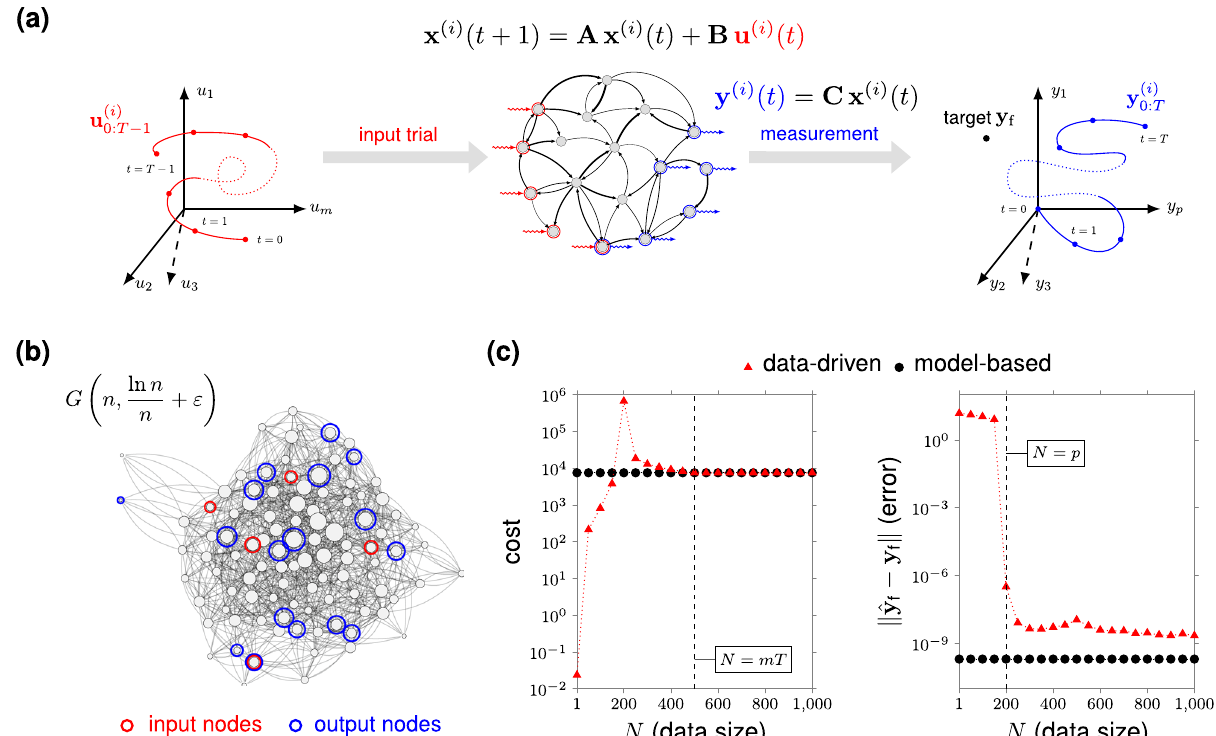
Fig. 2 Experimental setup and optimal data-driven network controls. Panel ( a ) illustrates the data-collection process. With reference to the i th control experiment, a T -step input sequence u ð i Þ excites the network dynamics in Eq. (1), and the time samples of the resulting output trajectory y ð i Þ are recorded. 0 : T 0 : T The input trajectory u ð i Þ may be generated randomly, so that the fi nal output y ð i Þ T does not normally coincide with the desired target output y f . Red nodes 0 : T denote the control or input nodes (forming matrix B ) and the blue nodes denote the measured or output nodes (forming matrix C ). Panel ( b ) shows a realization of the Erdös – Rényi graph model G ( n , p edge ) used in our examples, where n is the number of nodes, p edge is the edge probability. We set the edge ffiffiffi p n probability to p ¼ lnn = n þ ε , ε = 0.05, to ensure connectedness with high probability, and normalize the resulting adjacency matrix by . Panel ( c ) edge shows the value of the cost function (left) and the (norm of the) error in the fi nal state (right) for the data-driven input (4) and the model-based control as a function of the number of data points. The symbol y f denotes the desired fi nal target and ^ y the output reached by the (model-based or data-driven) f control input. We choose Q = R = I , n = 1000, T = 10, m = 50, and p = 200, and consider Erdös – Rényi networks as in panel ( b ). For additional details, see “ Methods ”